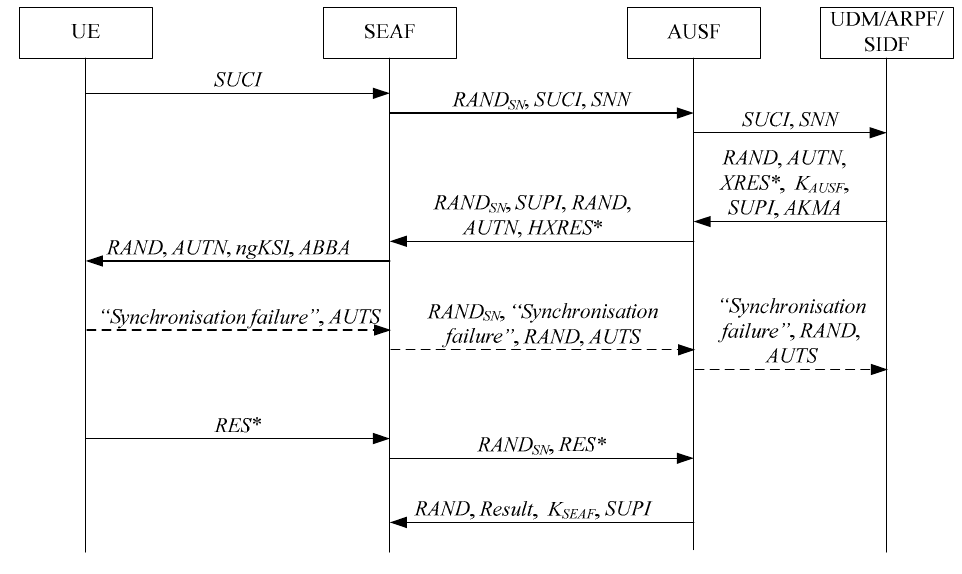
Figure 23. Our proposed 5G-AKA’ protocol.